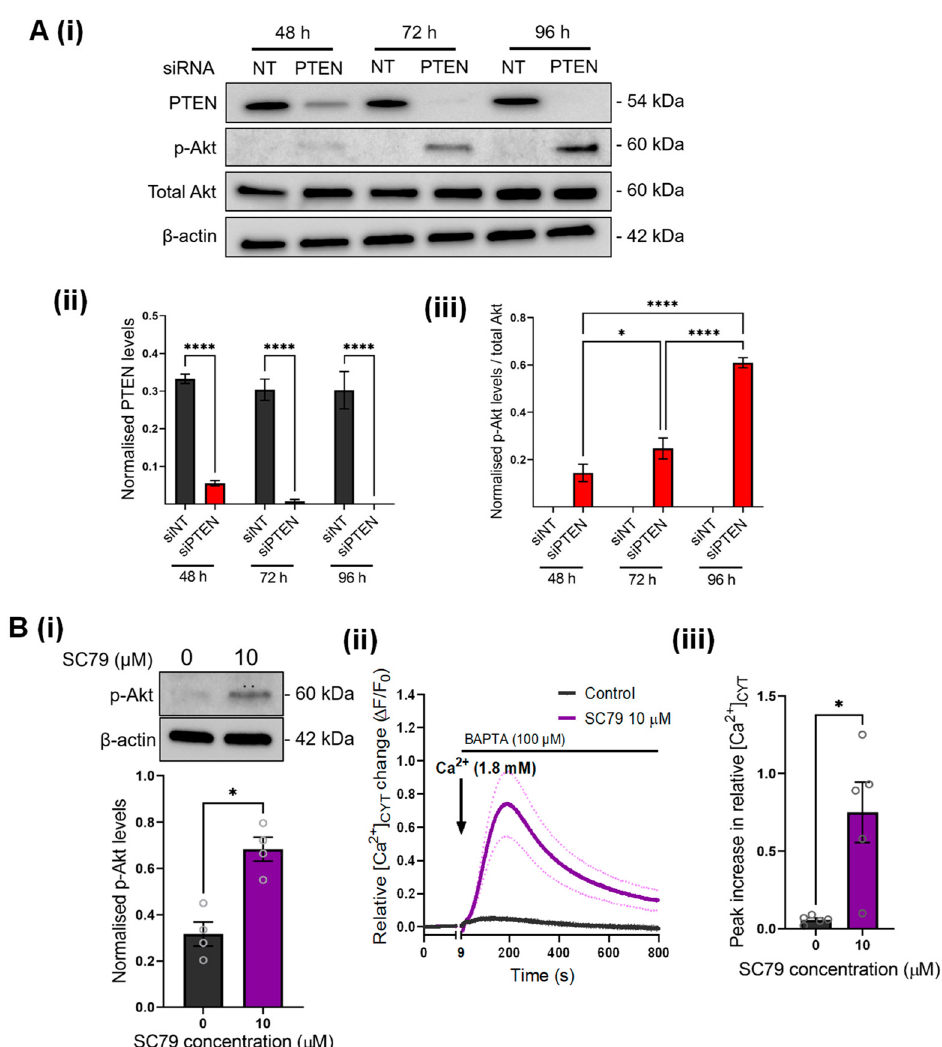
Figure 2. PTEN silencing and SC79 promote AKT phosphorylation in GCaMP6m-MDA-MB-231 cells and increase Ca 2+ influx. ( A ) (i) Immunoblot shows the effect of siPTEN on protein levels of PTEN and phosphorylated AKT (p-Akt) at 48, 72 and 96 h post-transfection. Bar graphs compare (ii) PTEN and (iii) p-Akt levels in siNT and siPTEN treated cells at 48, 72 and 96 h post-transfection. Statistical analyses were done using a repeated measures one-way ANOVA with Bonferroni’s multiple comparisons test. **** p < 0.001; * p < 0.05. ( B ) (i) Representative immunoblot and bar graph showing the effect of SC79 (10 µ M) 1 h incubation on p-Akt levels. (ii) Trace shows the mean relative [Ca 2+ ] CYT increase in GCaMP6m-MDA-MB-231 cells incubated with SC79 (10 µ M) for 1 h. (iii) Bar graph compares the mean peak relative increase in [Ca 2+ ] CYT between 0 µ M and 10 µ M SC79 treatments. Statistical analyses for ( B ) were performed using paired t-tests (n = 5). * p < 0.05. Uncropped Western blots in Figure